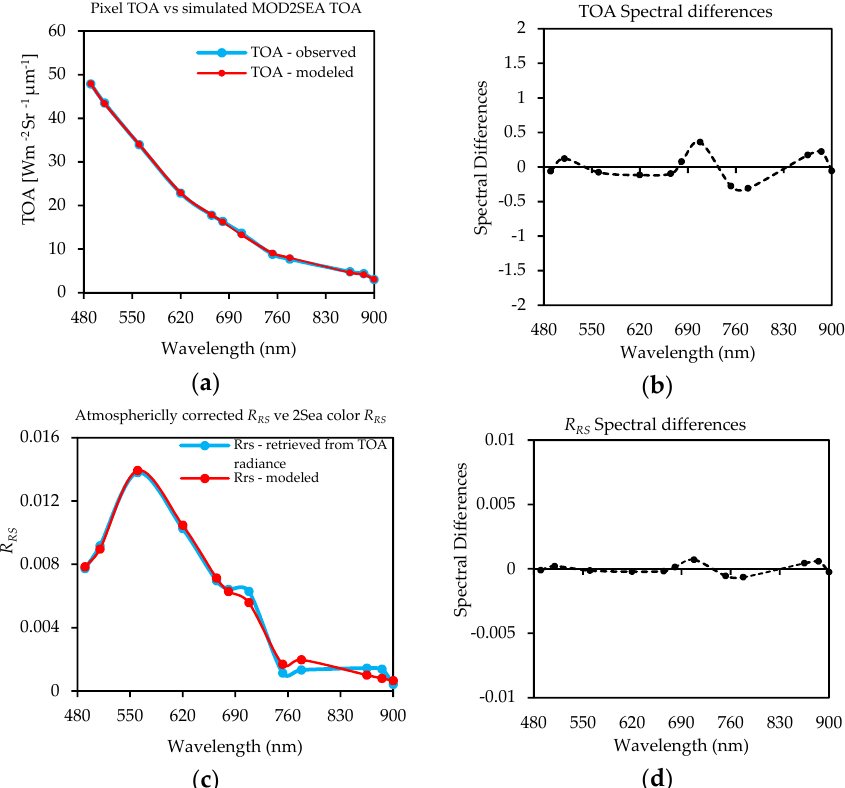
Figure 9. ( a ) The best match identified by the coupled model between simulated TOA radiances vs. pixel TOA radiance; ( b ) Spectral differences between observed and simulated TOA radiance; ( c ) The simulated R RS (extracted from the best TOA radiance match) vs. the simulated 2SeaColor R RS ; ( d ) Spectral differences between simulated R RS by 2SeaColor and atmospherically corrected R RS from observed TOA radiance by MOD2SEA.